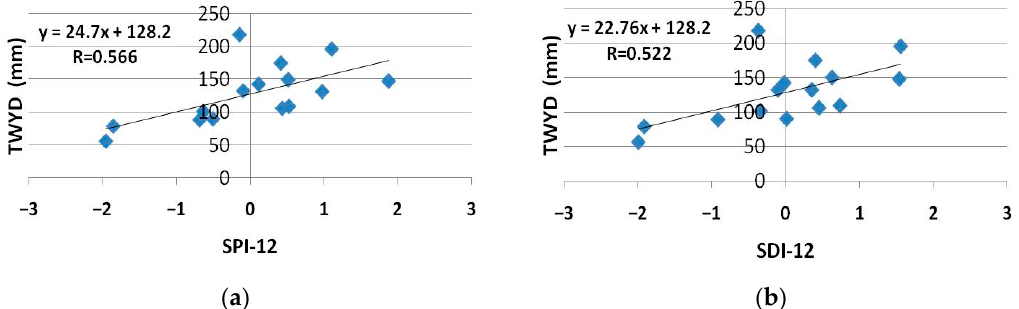
Figure 9. Scatter plot for correlation tests between annual historical TWYD and historical ( a ) SPI-12 and ( b ) SDI-12.